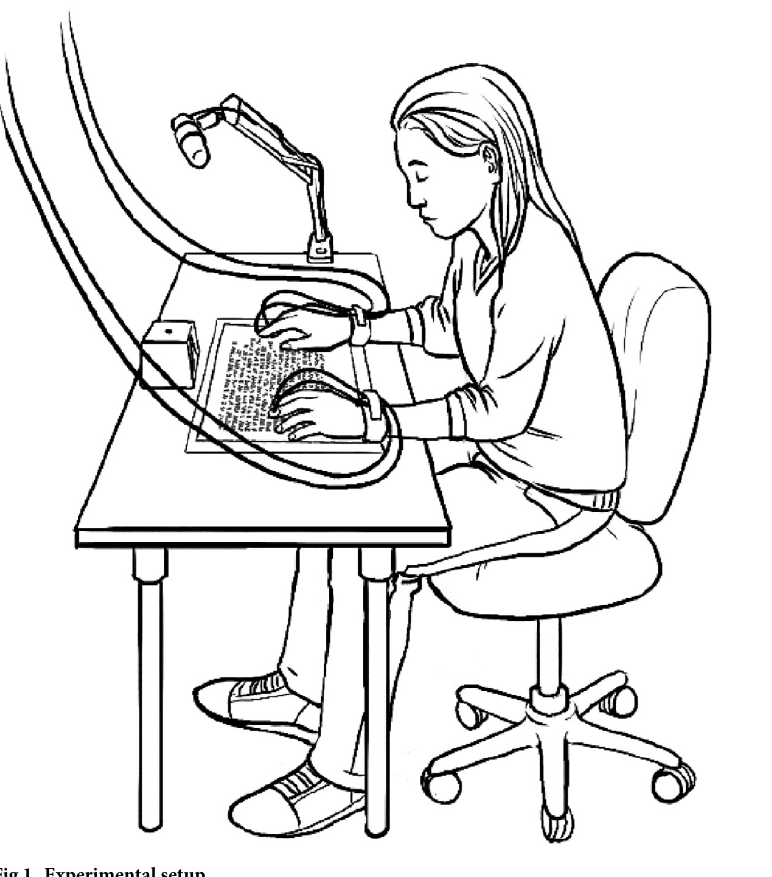
Fig 1. Experimental